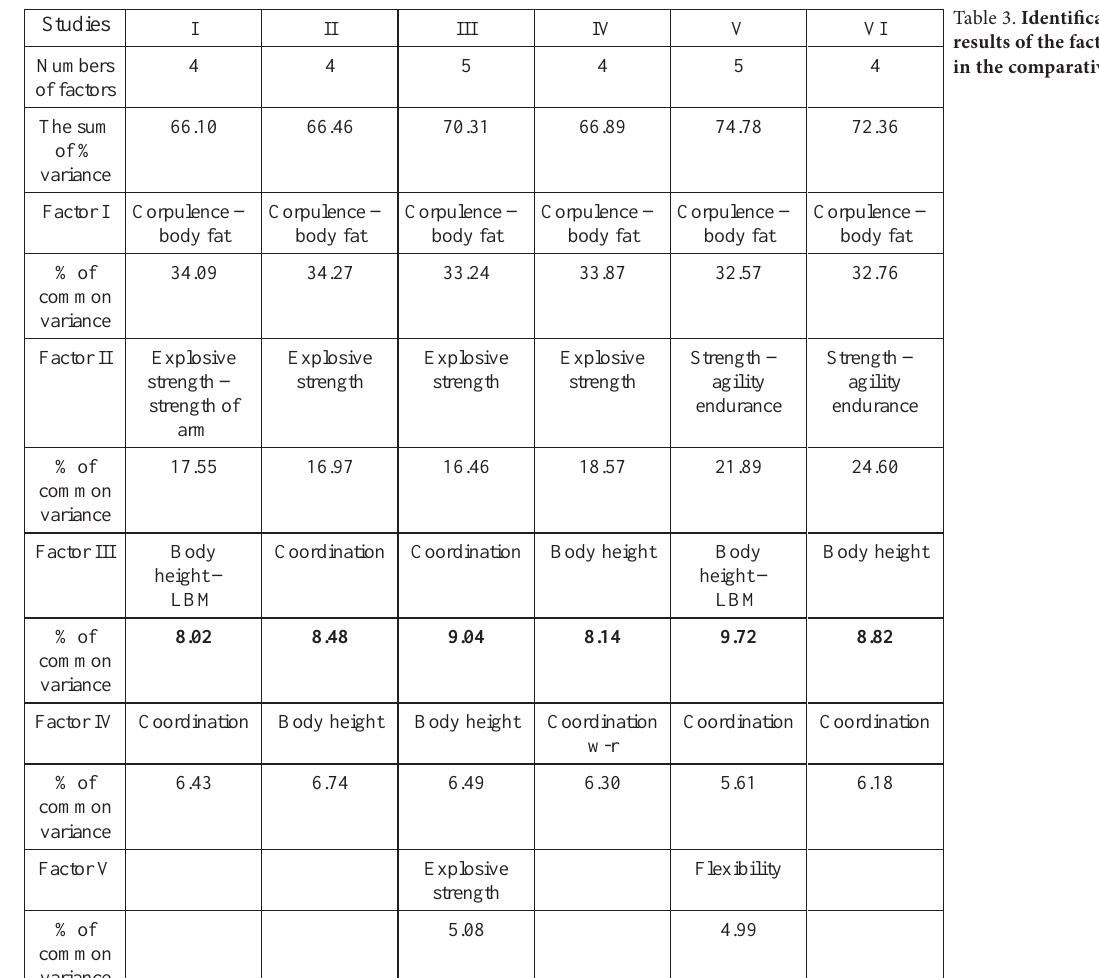
Table 3. Identifi cation of the results of the factor analysis in the comparative